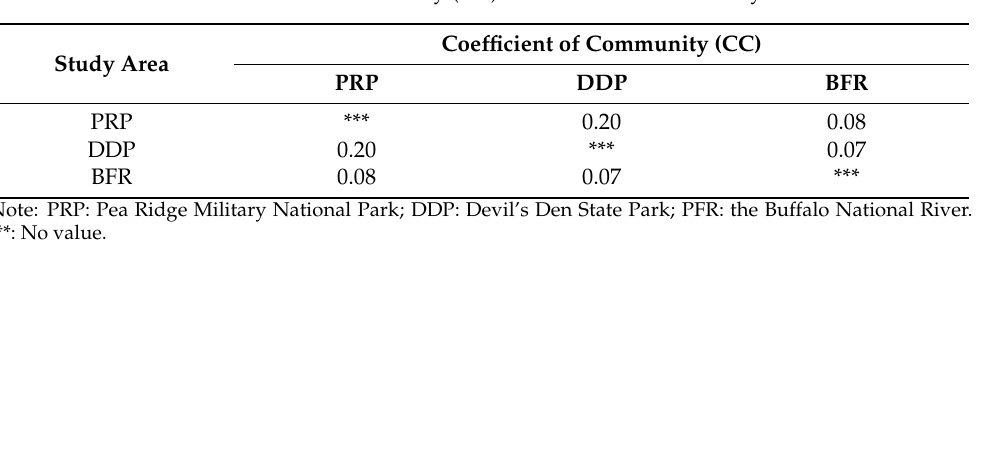
Table 5. Calculation Coefficient of community (CC) indices for the three study